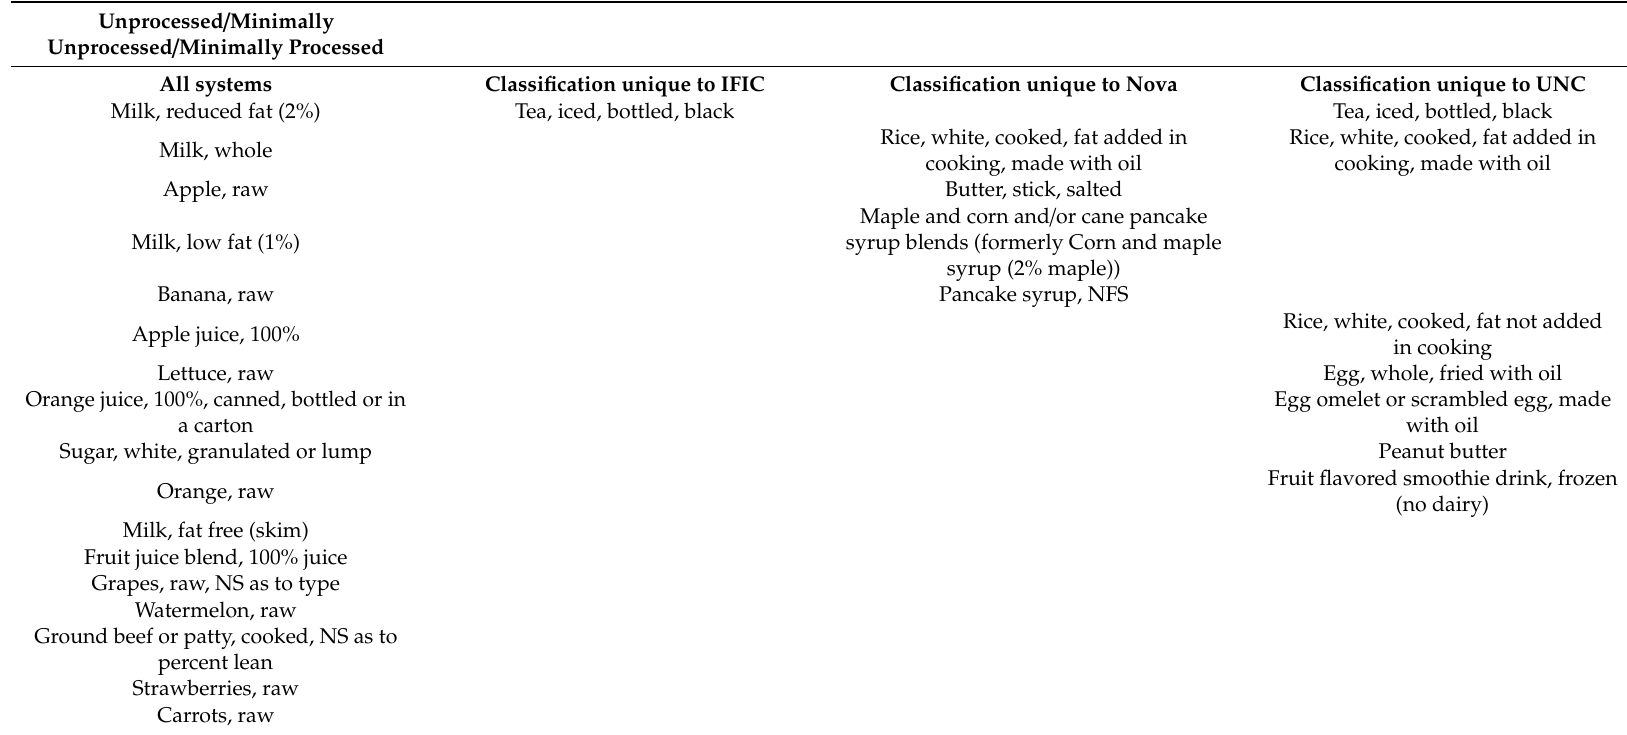
Table A1. Corresponding and discrepant processing category assignments among the IFIC, Nova, and UNC classification systems for the top 100 most commonly consumed foods among children 6–12 years old (NHANES